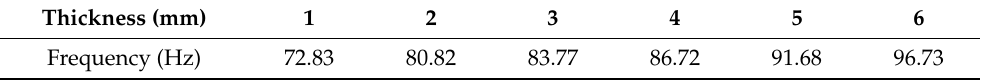
Table 4. Relationship between the thickness of substructure S 6,3 and first natural frequency of the tank. Thickness